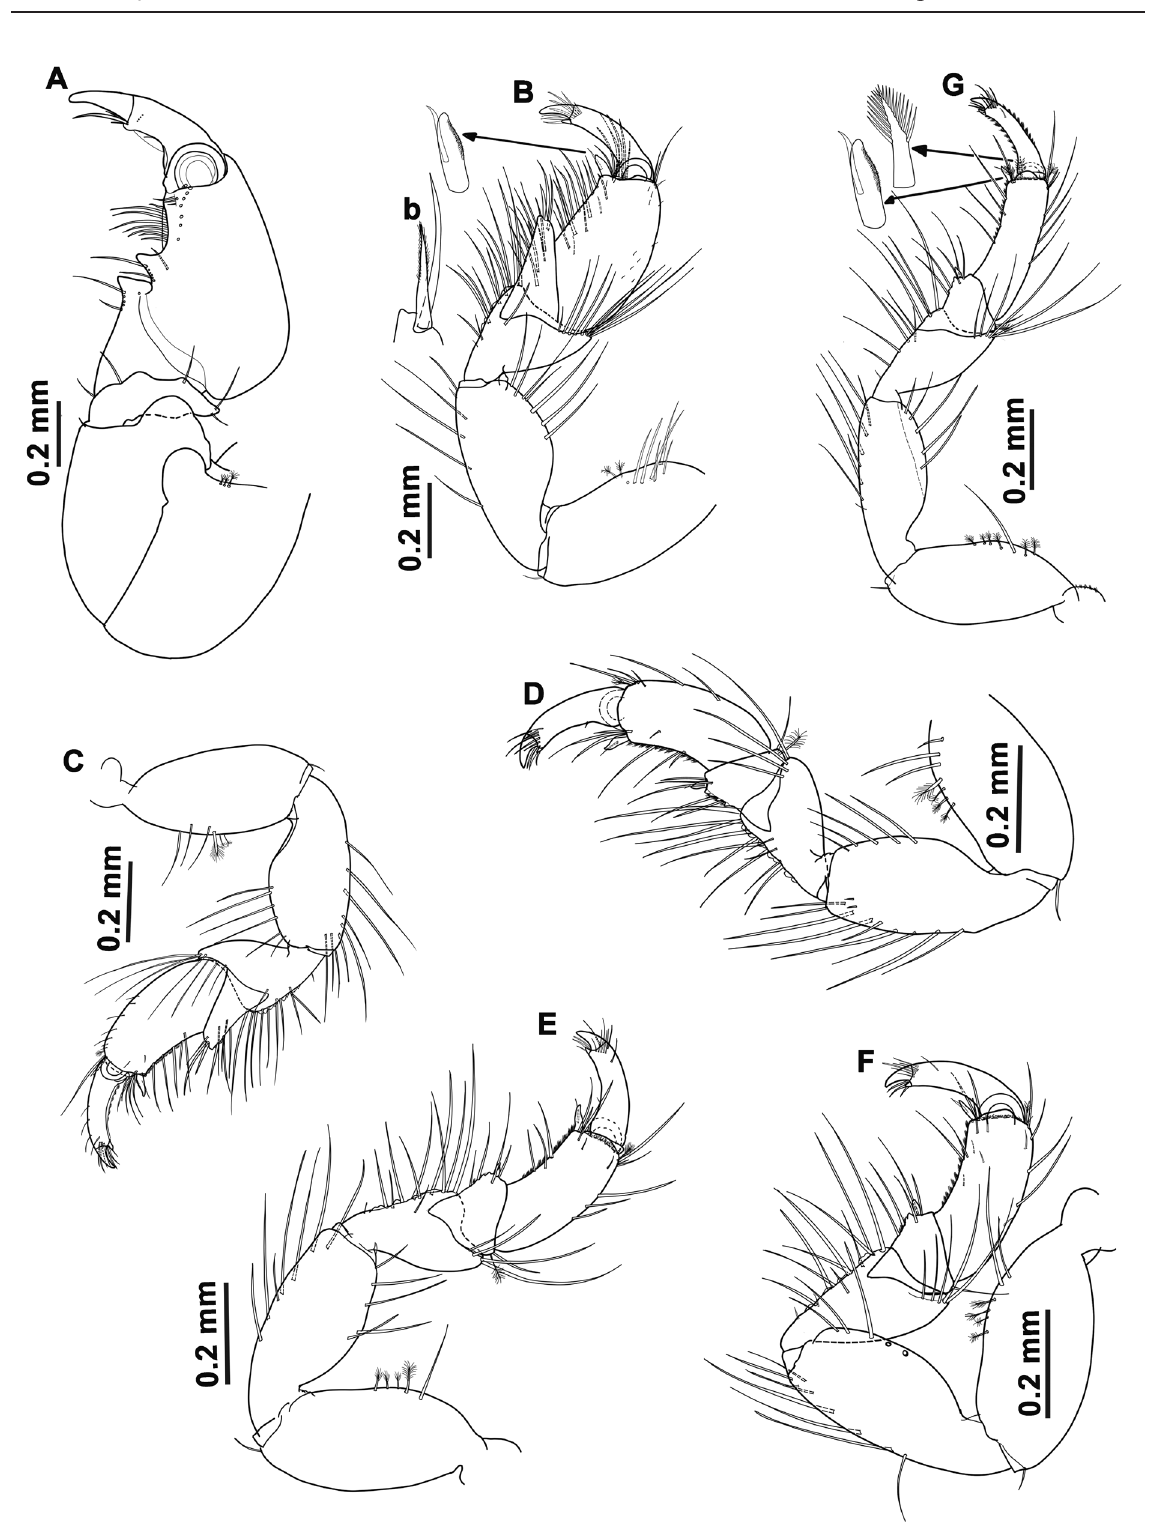
Fig. 15. Skuphonura oaxaquensis sp. nov., holotype, ♀, 7.9 mm, Oaxaca, Puerto Ángel, Estacahuite Beach (UMAR-PERA 548). A . Pereopod 1. B . Pereopod 2 and detail of the carpus (b) and sensory spine. C . Pereopod 3. D . Pereopod 4. E . Pereopod 5. F . Pereopod 6. G . Pereopod 7 and detail of the sensory